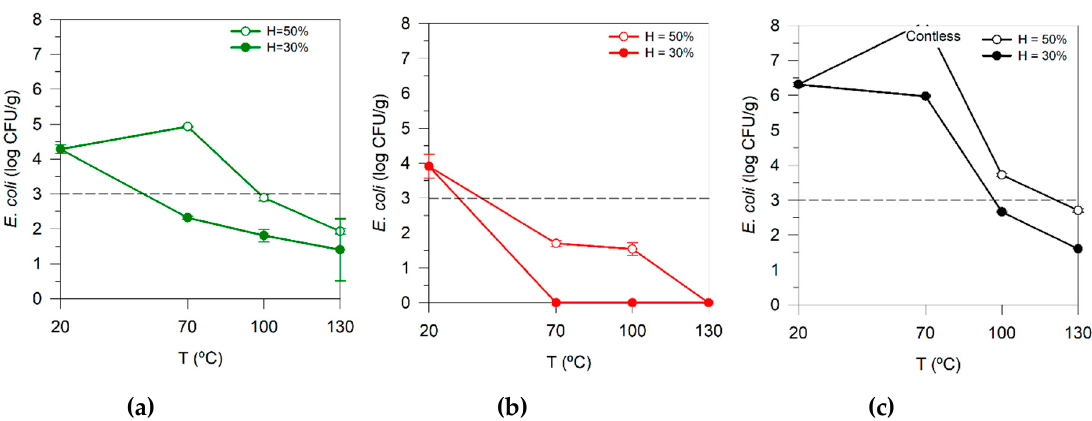
Figure 5. E. coli enumeration during the thermal treatment at different temperatures and moisture for ( a ) UM4, ( b ) AD1.3, and ( c ) AD1.4 samples.